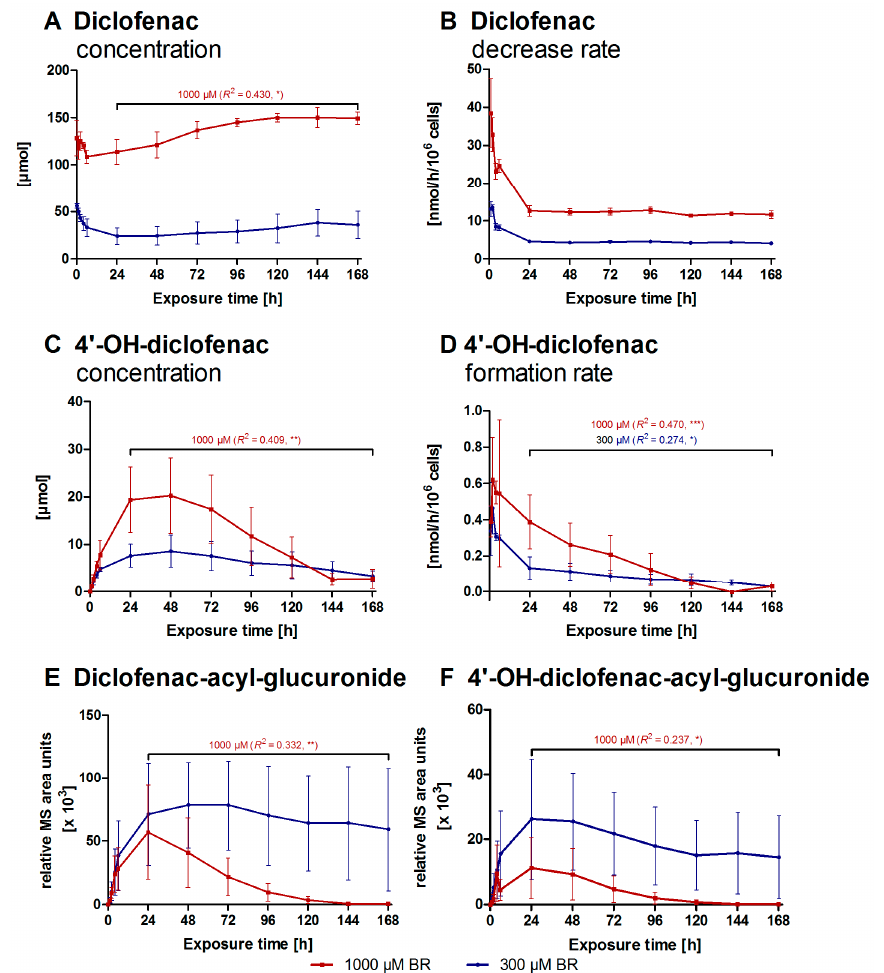
Figure 5. Conversion of diclofenac to specific metabolites in bioreactors with primary human liver